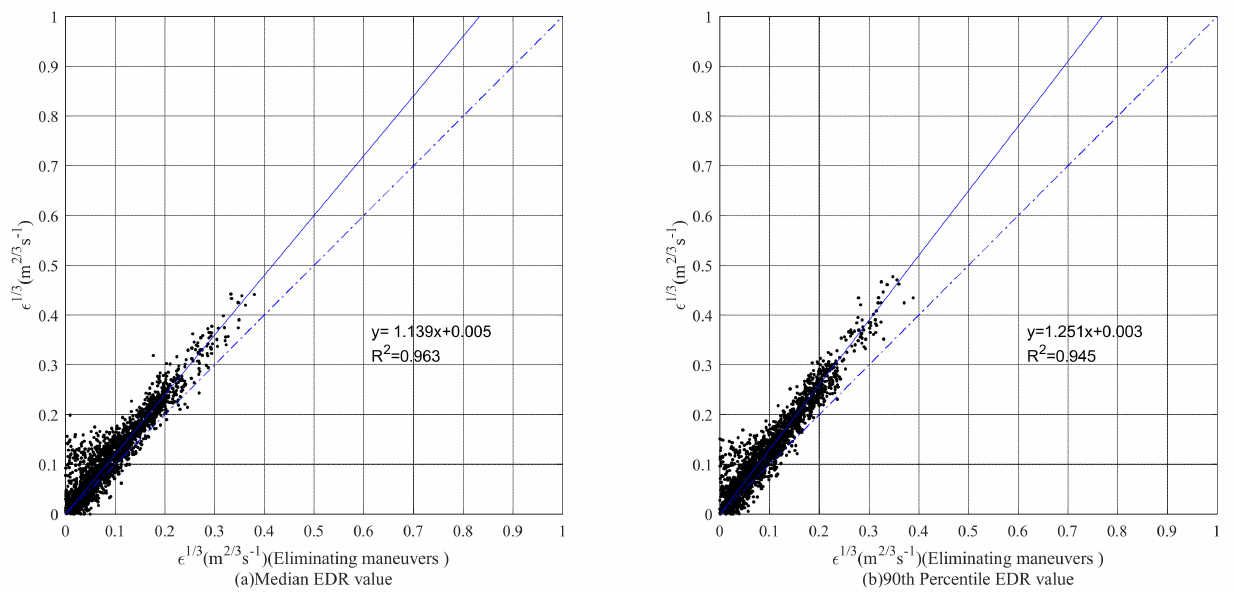
Figure 11. The comparison of the derived EDR value: ( a ) the scatterplot of the one-minute median EDR values. ( b ) the scatterplot of the 90th percentile EDR